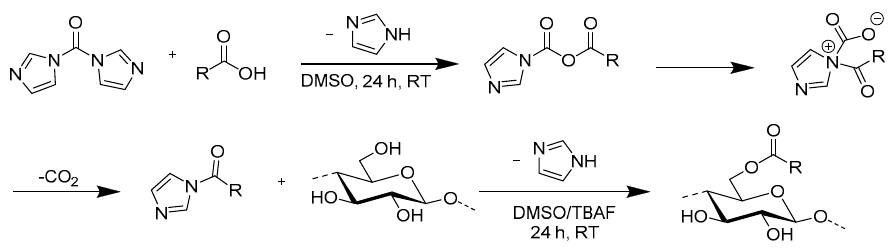
Figure 13. Schematic demonstration of CDI activation of carboxylic acids; redrawn from [141].